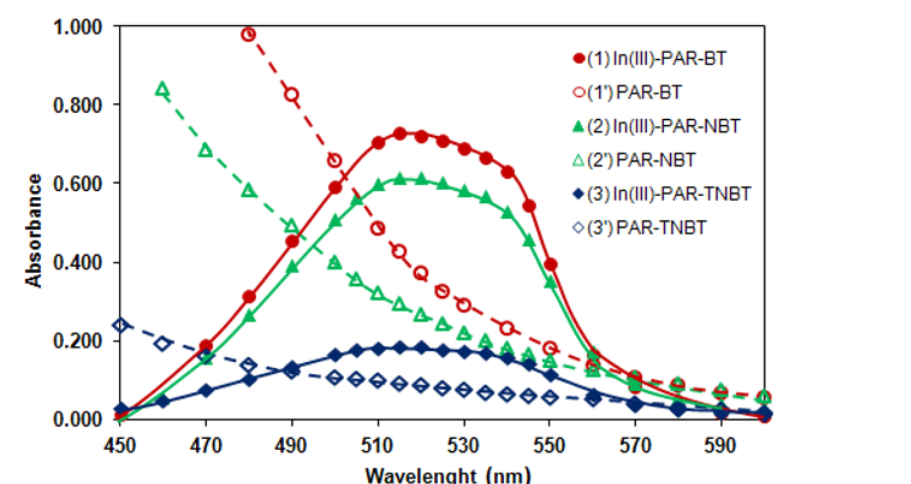
Figure 1. Absorption spectra of the ternary complexes (curves 1-3) and blank samples (curves 1’-3’) in chloroform. C